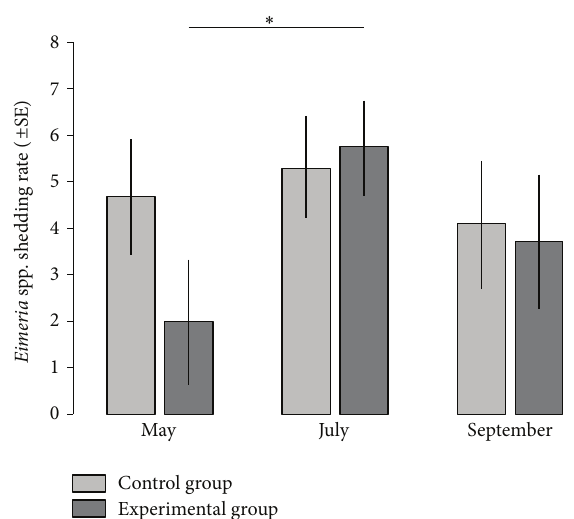
Figure 2: Effect of anthelmintic treatment on the faecal shedding rate of Eimeria spp. oocysts in the Alpine marmot, M. mar- mota latirostris . The Eimeria spp. shedding rate represents log- transformed oocyst numbers per gram of a faecal sample. The symbol above line ∗ refers to 𝑃 < 0.05 . The 𝑃 value reported is adjusted for multiple comparisons using the Bonferroni single-step